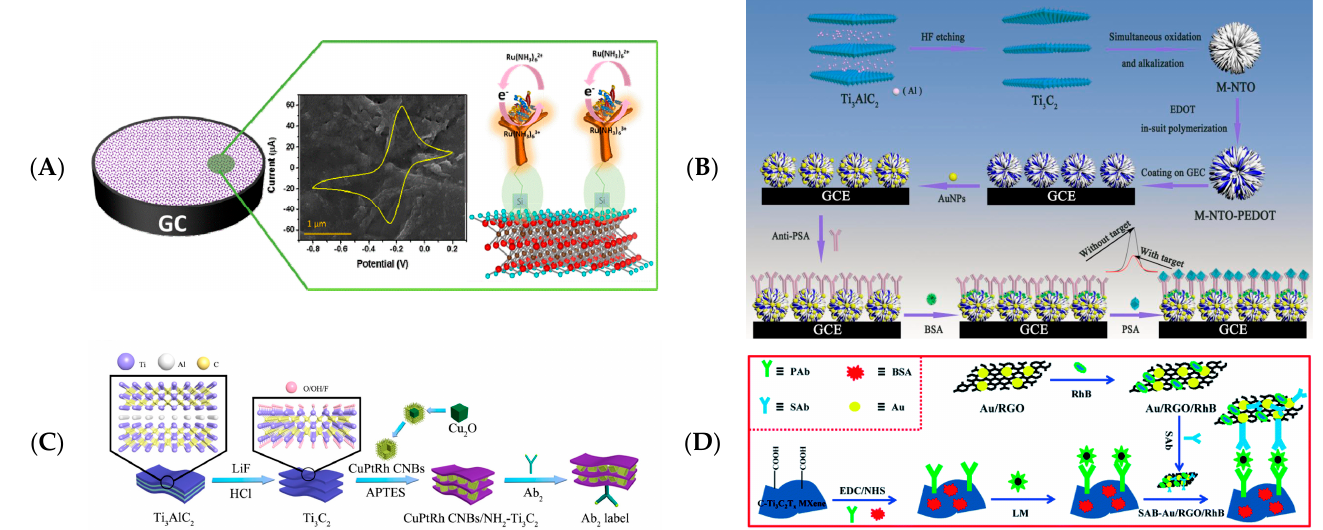
Figure 8. ( A ) Schematic diagram of the detection mechanism of electrochemical CEA. Reprinted with permission from Ref. [84]. Copyright 2018, Elsevier. ( B ) The fabrication and detection steps of the immunosensor. Reprinted with permission from Ref. [86]. Copyright 2020, Elsevier. ( C ) Schematic diagram of the fabrication of the working electrode of the immunosensor. Reprinted with permission from Ref. [87]. Copyright 2020, American Chemical Society. ( D ) Illustrations for constructing the sandwich-like immunosensor of LM based on Ti 3 C 2 T x MXene. Reprinted with permission from Ref. [88]. Copyright 2021, Royal Society of Chemistry.